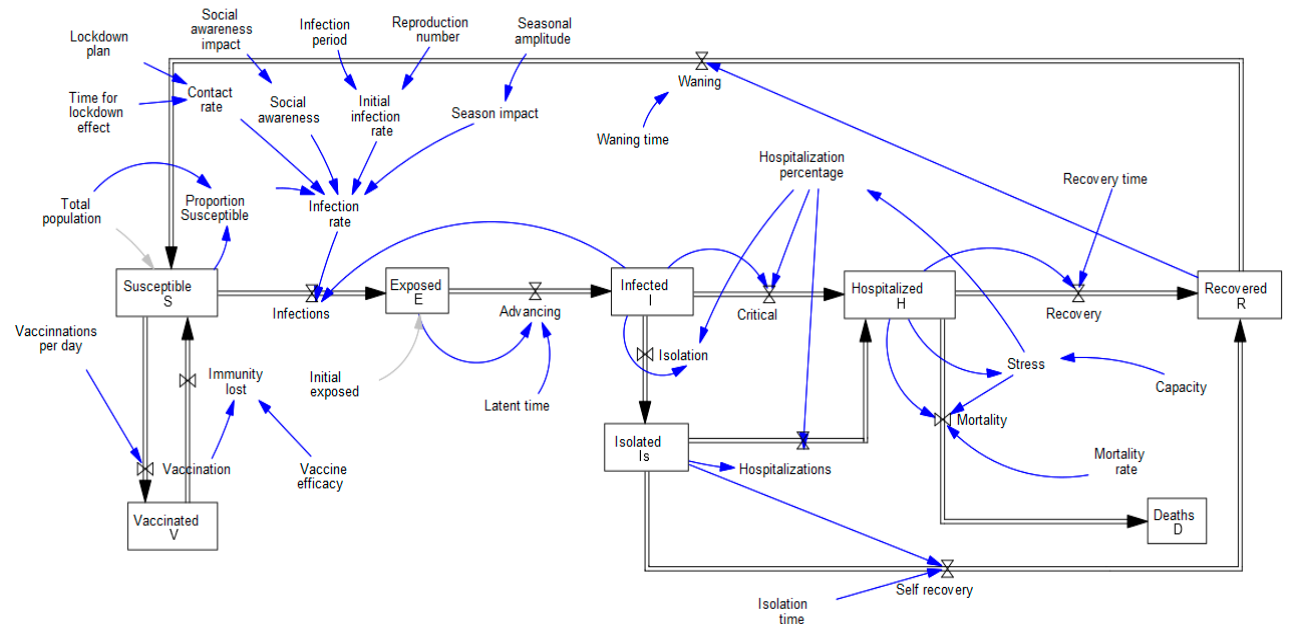
Figure 1. Stock and Flow diagram for the COVID-19 pandemic model.